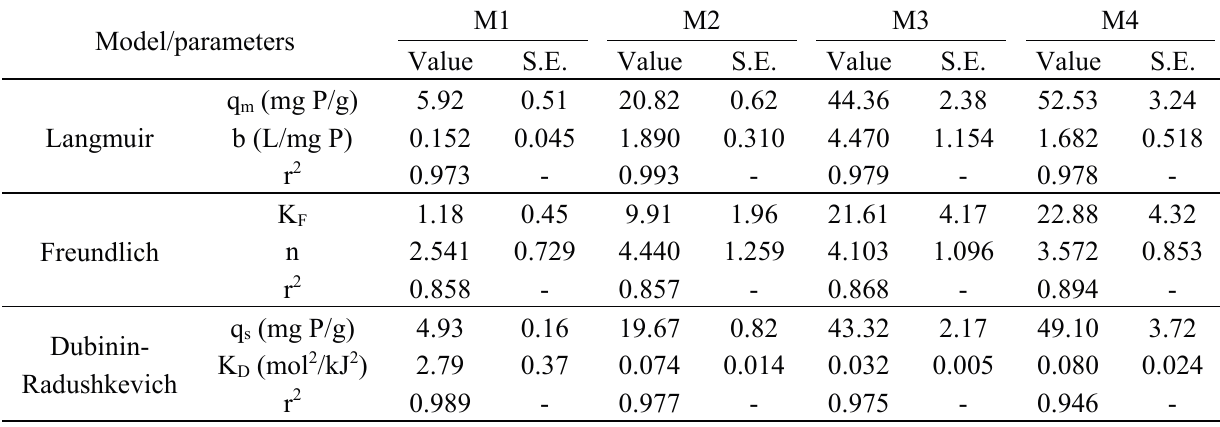
Table 3. Langmuir, Freundlich and Dubinin-Radushkevich isotherm parameters obtained by nonlinear fitting for the four adsorbents (M1, M2, M3 and M4). Model/parameters